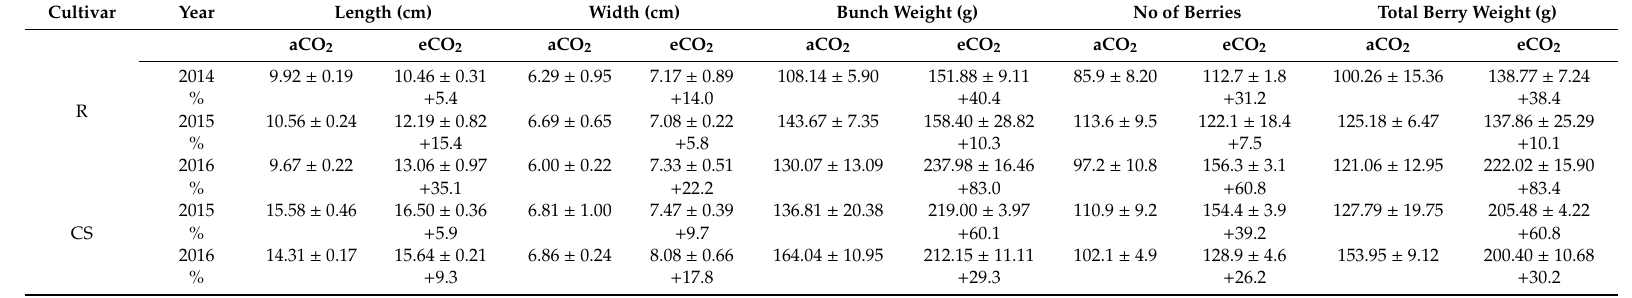
Values are the mean ± SD of three FACE rings per